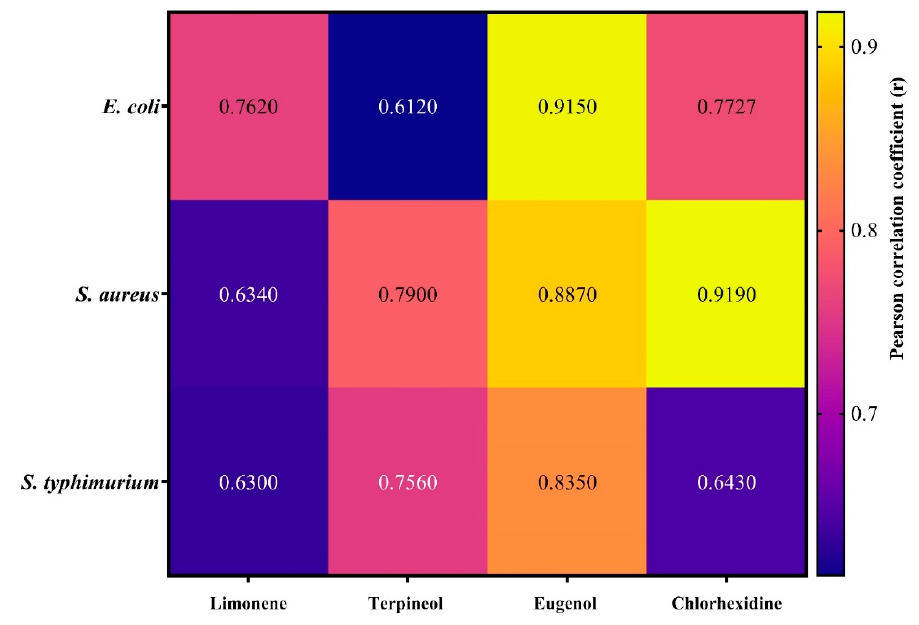
Figure 4. Pearson correlation coefficient between biofilm biomass (OD in %) and biofilm viability (LR in log CFU cm − 2 ) for all three tested bacterial strains and active components.